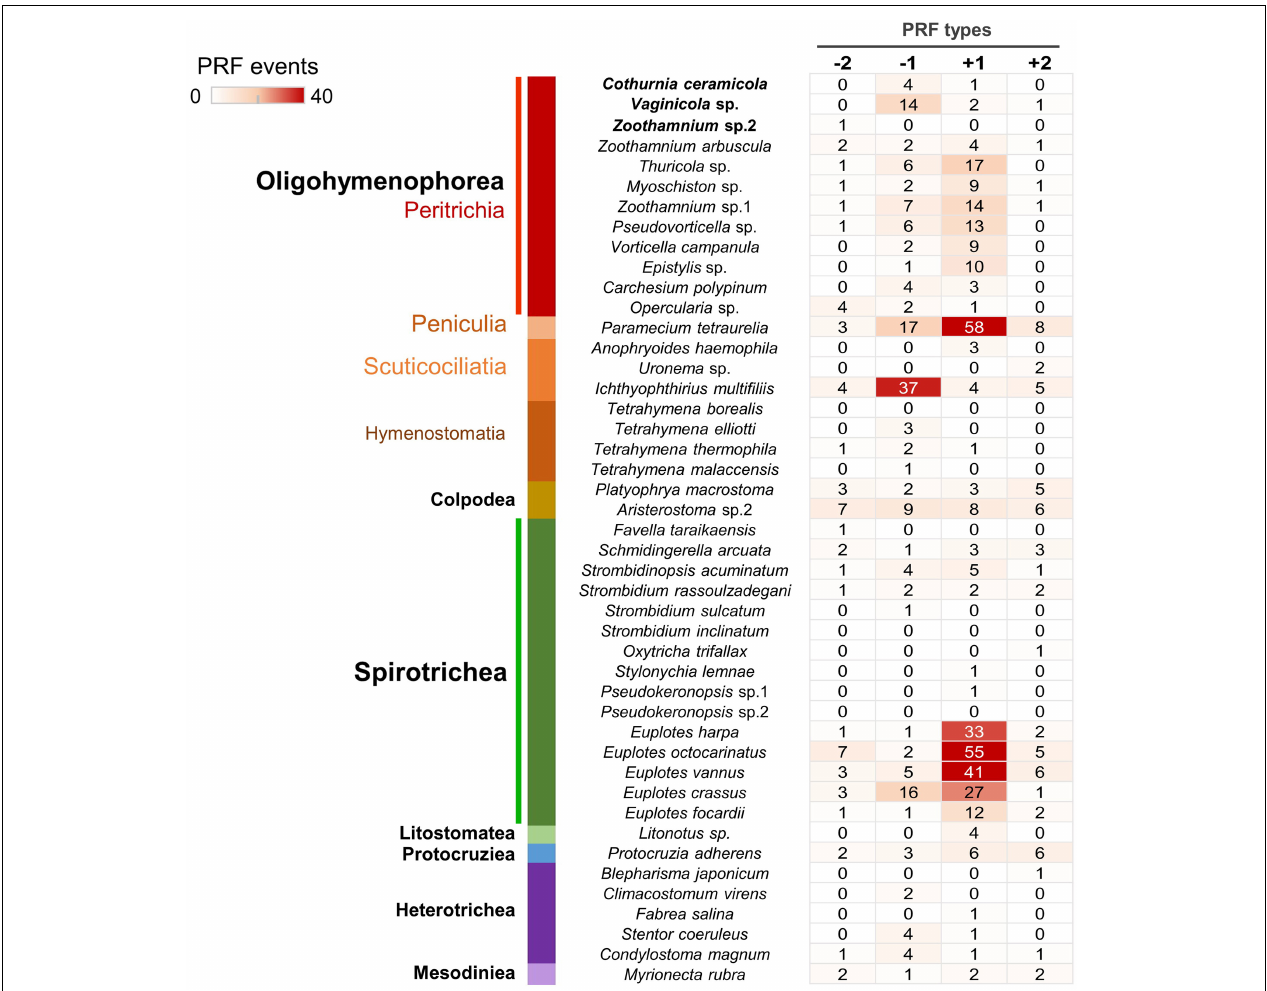
FIGURE 4 | Systematic investigation of programmed ribosomal frameshifting (PRF) events in ciliate genomes reveals that +1 and -1 PRF events are prevalent in peritrichs. The color scale denotes the number of four types of PRF events in each species. The class names are labeled in bold, and the subclass names are labeled in